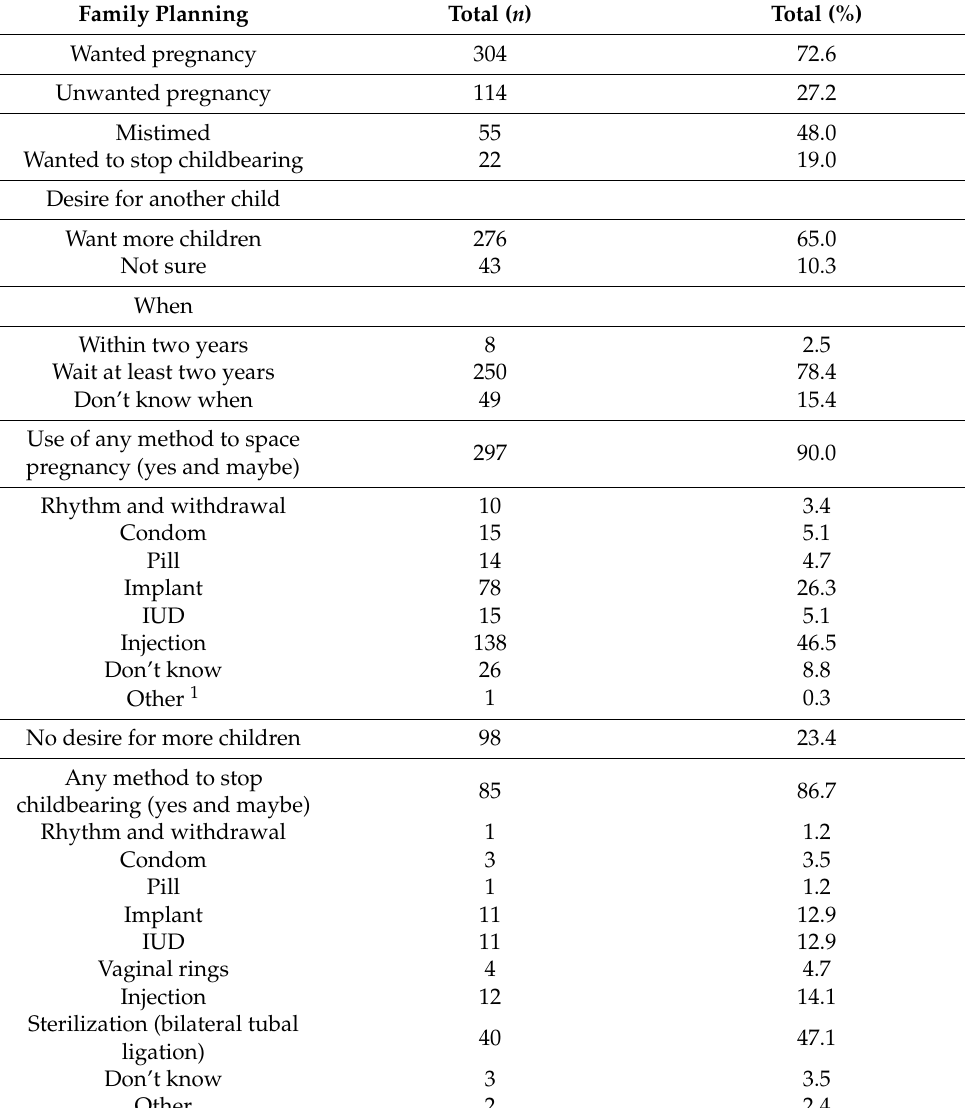
Table 3. Family planning among pregnant women (n = 419) at three hospitals in southern